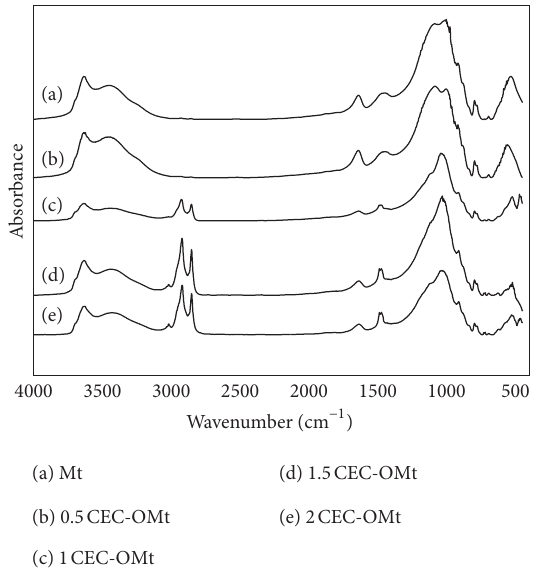
F 3: FTIR spectra of the pristine montmorillonite and the different